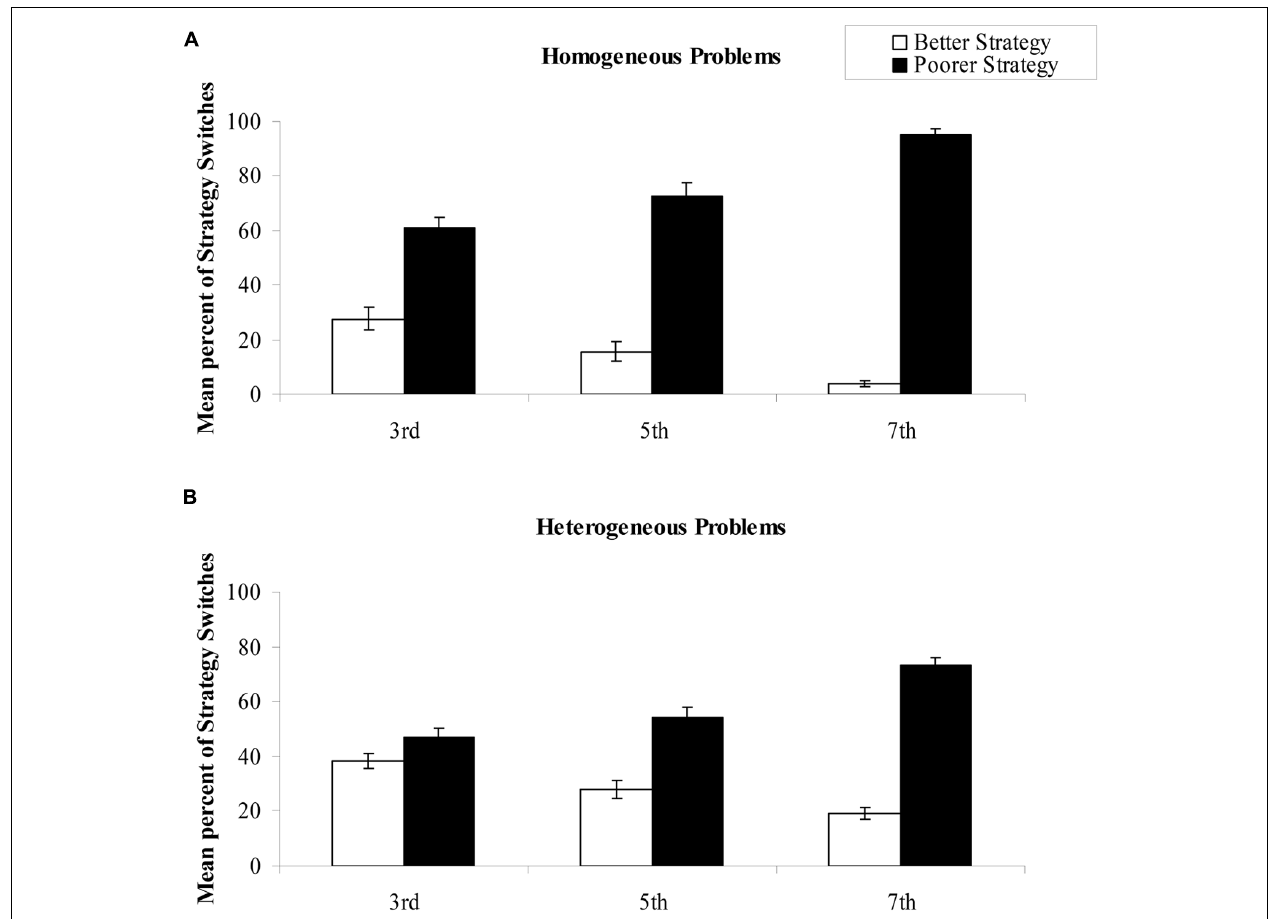
FIGURE 2 | Mean percentages of strategy switches for homogeneous (A) and heterogeneous (B) problems in eachAge × Cued Strategy